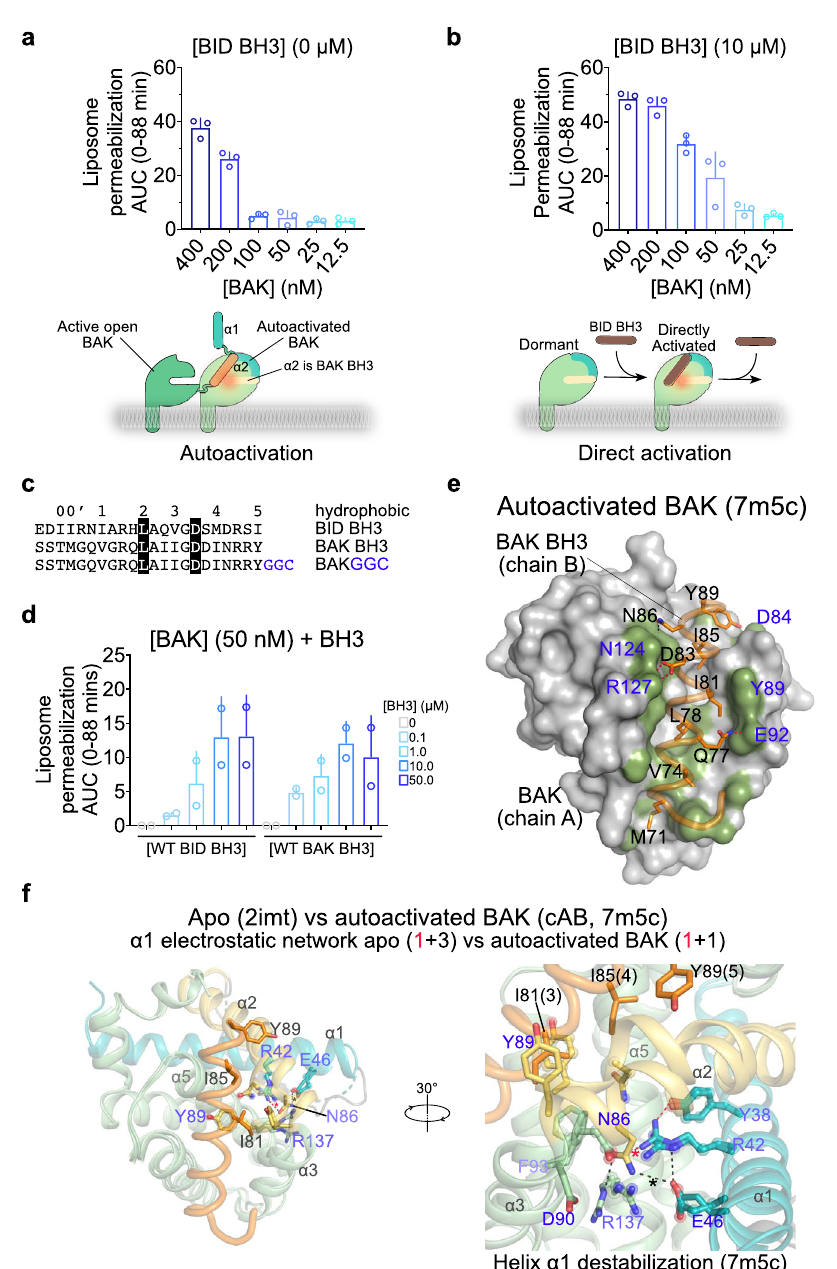
Fig. 1 BH3-in-groove BAK autoactivation by destabilization of helix α 1. a , b BAK autoactivation and direct activation revealed in liposome permeabilization assays quanti fi ed as area under the curve (AUC) of kinetic traces in Supplementary Figs. 1 a, b. Data are presented as mean + SD from one representative of n = 4 experiments each of n = 3 technical replicates. c BH3 peptide sequences. Conserved positions in BH3-only Initiators and Effectors are highlighted. The GGC linker (blue) was designed for covalent tethering to BAK G184C. d Liposome permeabilization assays quanti fi ed as AUC of kinetic traces from Supplementary Fig. 4 for WT BAK activation by WT BID and BAK BH3 peptides. Data are presented as mean + SEM of n = 2 experiments each of n = 3 technical replicates. e Surface representation of BAK in complex with BAK BH3 peptide showing van der Waals contacts ( ≤ 4 Å, green). f Overlay of apo and autoactivated BAK reveals the mechanistic basis of autoactivation as BAK BH3 binding-induced destabilization of the electrostatic network within the protein core at the interface of helices α 1, α 2, α 3, and α 5. Apo residues are rendered as sticks and spheres and their electrostatic network contacts (dashed lines) are excluded. Hydrogen bonds ≤ 3.2 Å (red) and ≤ 3.6 Å (black) between helix α 1 and the rest of the domain identi fi ed with * are summarized in brackets, Supplementary Fig. 2d and Supplementary Table